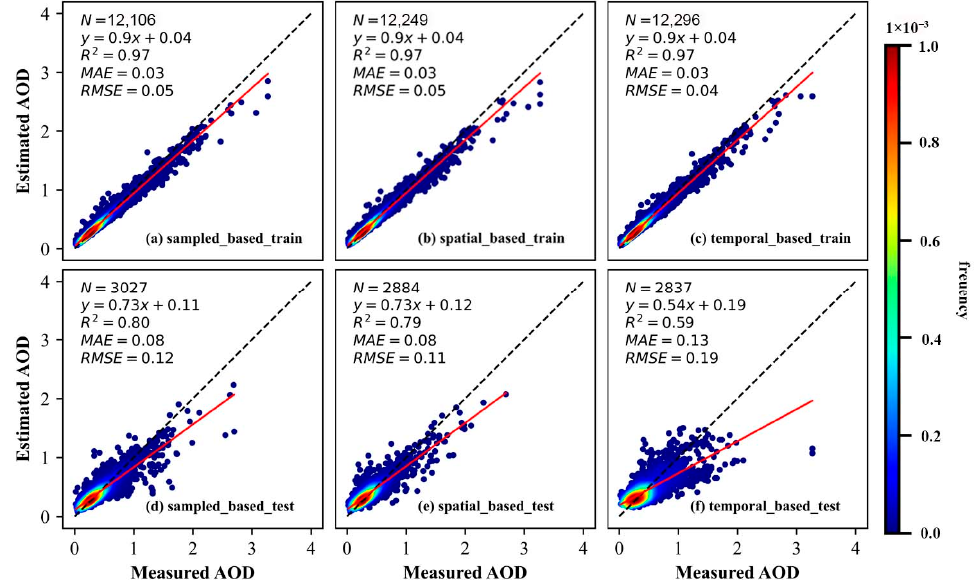
Figure 4. Density scatterplots of the RF model with sample, spatial, and temporal-based train examination results ( a – c ) and test evaluation results ( d – f ) for GWA. The black dash and solid red lines represent the 1:1 and linear regression lines, respectively.